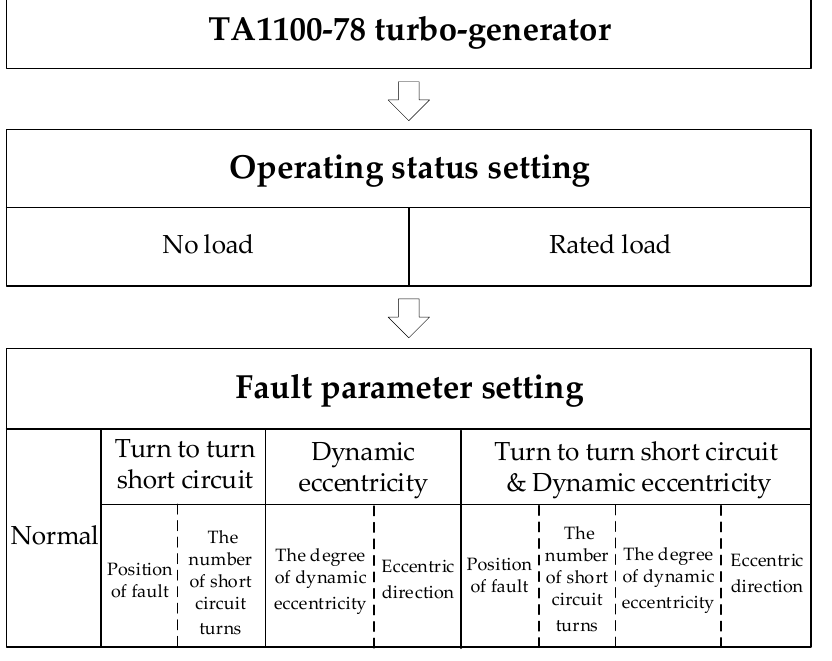
Energies 2019 , 12 , x FOR PEER REVIEW Figure 4. Schematic diagram of the simulation. Figure 4. Schematic diagram of the simulation.